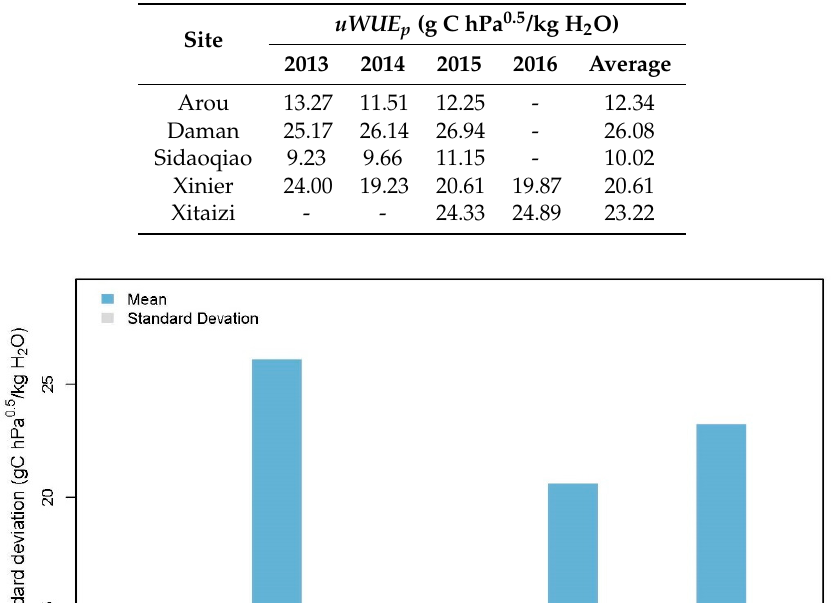
Table 2. A comparison of annual uWUE p for the five sites.